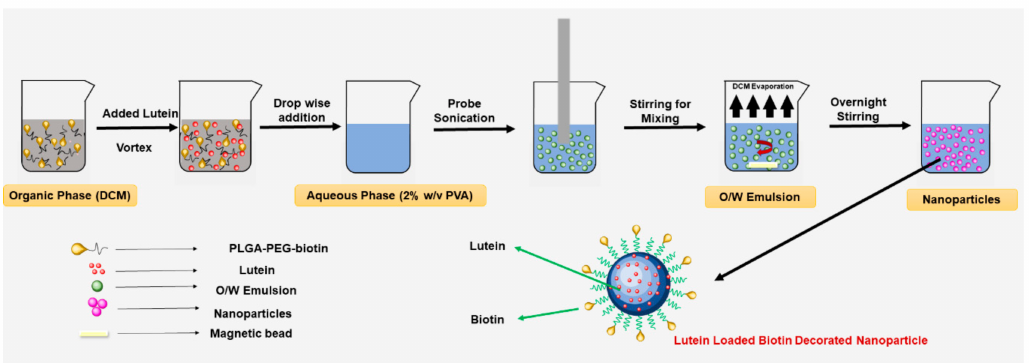
Figure 1. Schematic representation of oil in water emulsion-solvent evaporation method for preparation of lutein loaded PLGA-PEG-biotin